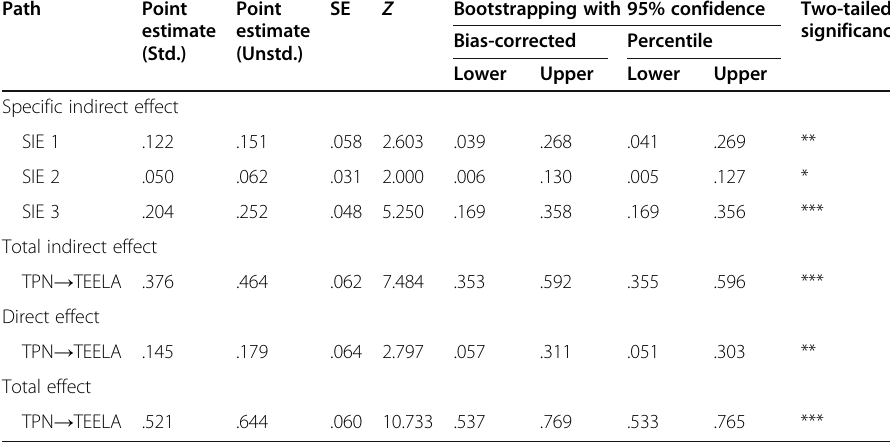
Table 6 Direct, indirect, and total effects of the hypothesized model Path Point Point SE Z Bootstrapping with 95% confidence Two-tailed estimate estimate significance Bias-corrected Percentile (Std.) (Unstd.) Lower Upper Lower Upper SIE 1 .122 .268 .041 .269 ** SIE 2 .050 .062 .031 2.000 .006 .130 .005 .127 * SIE 3 .204 .252 .048 5.250 .169 .358 .169 .356 *** TPN → TEELA .376 *** TPN → TEELA .145 .179 .303 ** TPN → TEELA .521 .644 .769 .533 .765 ***